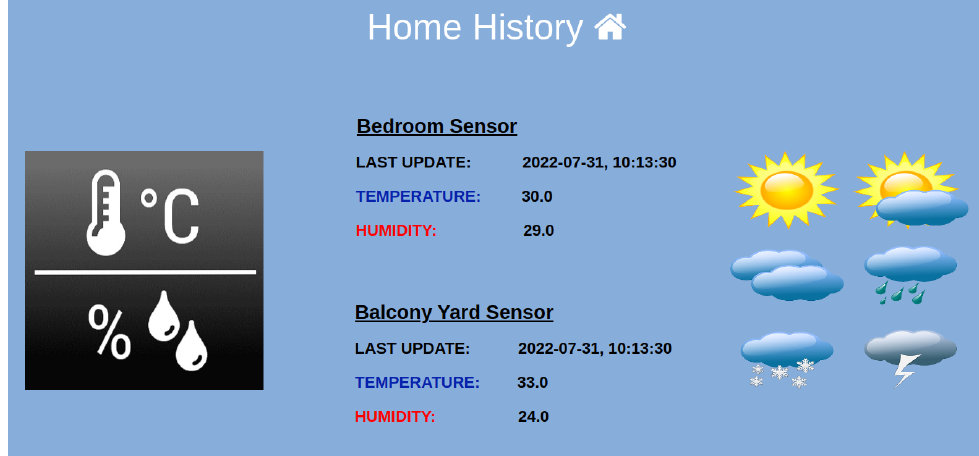
Figure 7. Latest temperature/humidity update from indoor and outdoor